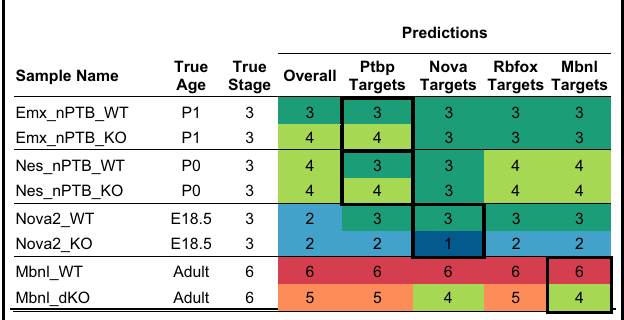
The color codes are the same as Fig. 3